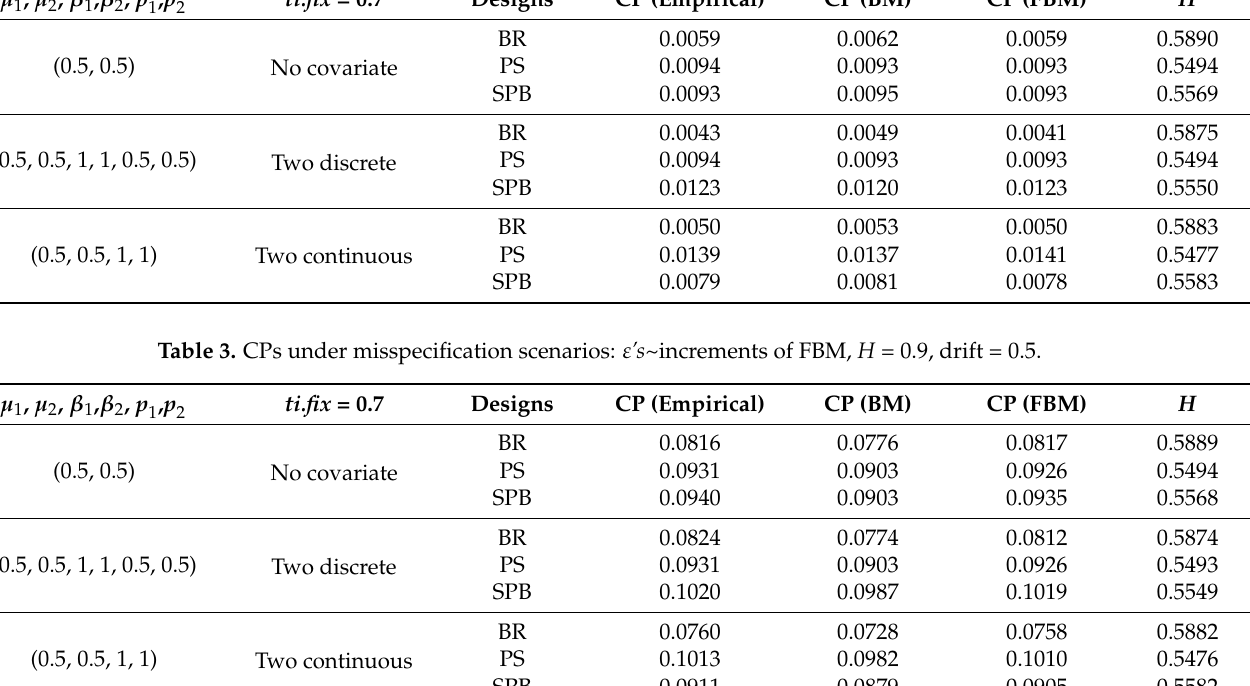
Table 2. CPs under misspecification scenarios: ε ’s ~increments of FBM, H = 0.9, drift = 0. , p µ 1 , µ 2 , β 1 , β 2 , p 1 2